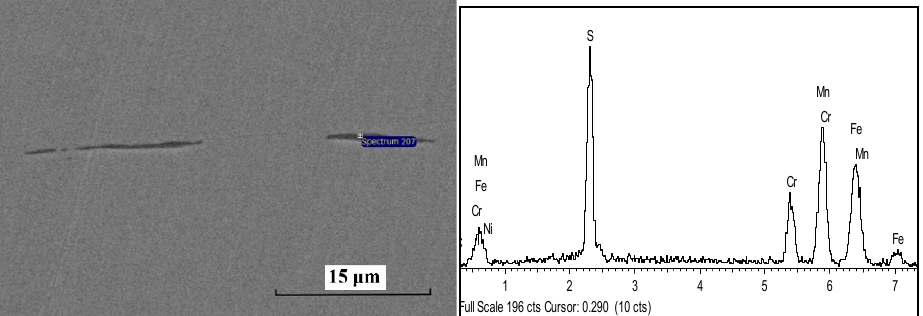
Figure 20. Typical MnS inclusions in hot rolled plates.